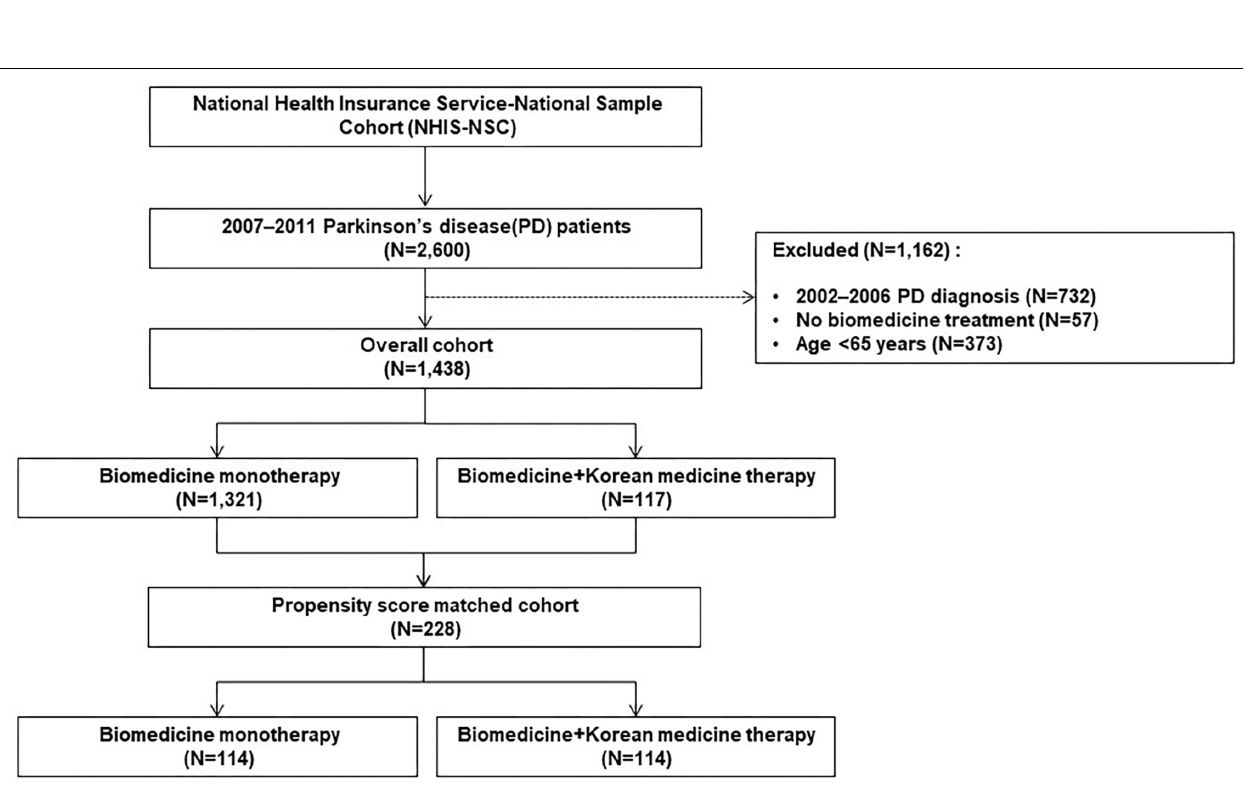
FIGURE 2 | Selection of